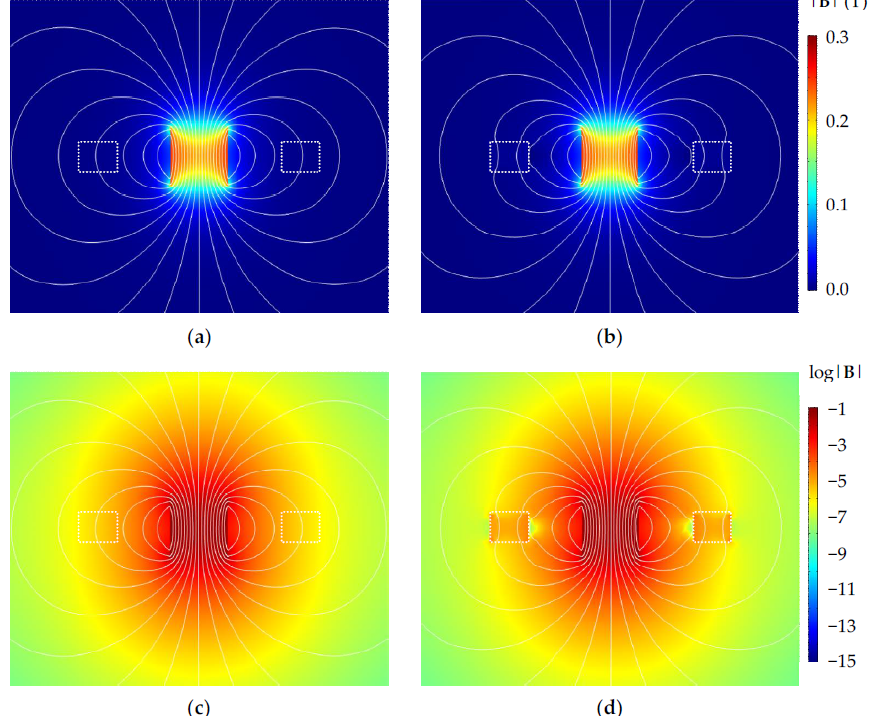
Figure 3. Magnetic flux density calculation showing B field magnitude and flux lines. The magnet is in the center and the cavities are outlined in white squares. ( a , b ) Cavities without and with ferrofluid (FF), respectively, in linear scale; ( c , d ) cavities without and with FF ( µ r = 18), respectively, in log scale.